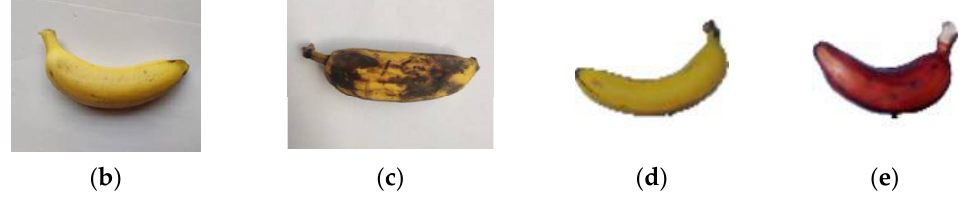
Figure 2. Ripening stages of banana fruits of the created custom dataset: ( a ) unripe, ( b ) ripe, and ( c ) over-ripe; for Fruit 360 dataset, Atapted with permission from Ref. [23]. Copyright © 2017-2021 Mihai Oltean: ( d ) ripe and ( e ) over-ripe.